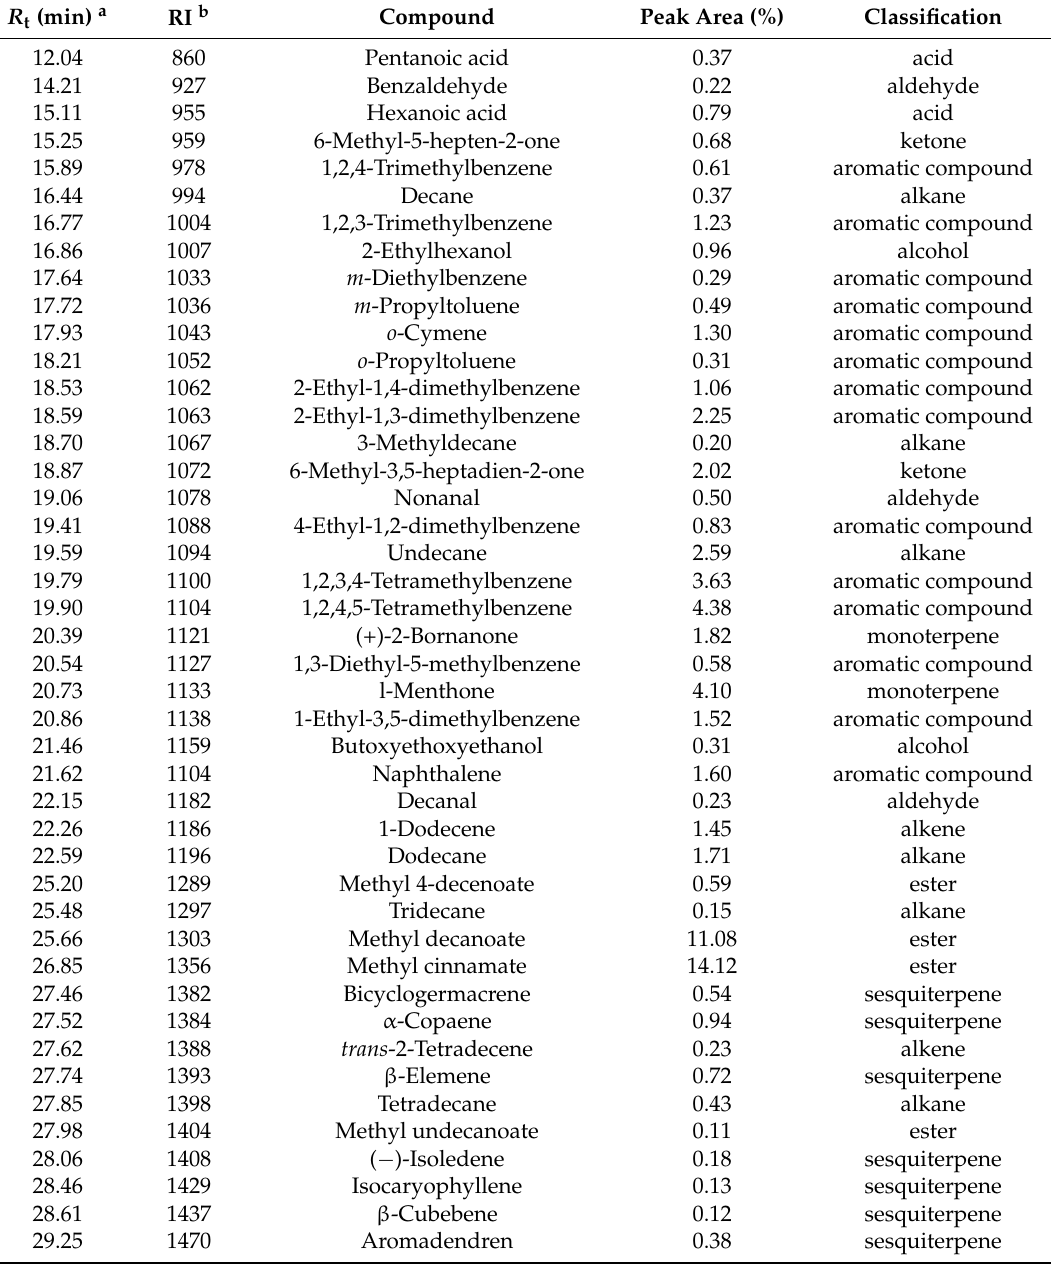
Table 1. Chemical composition of n -hexane-soluble fraction from purple I. batatas leaves. R t (min)